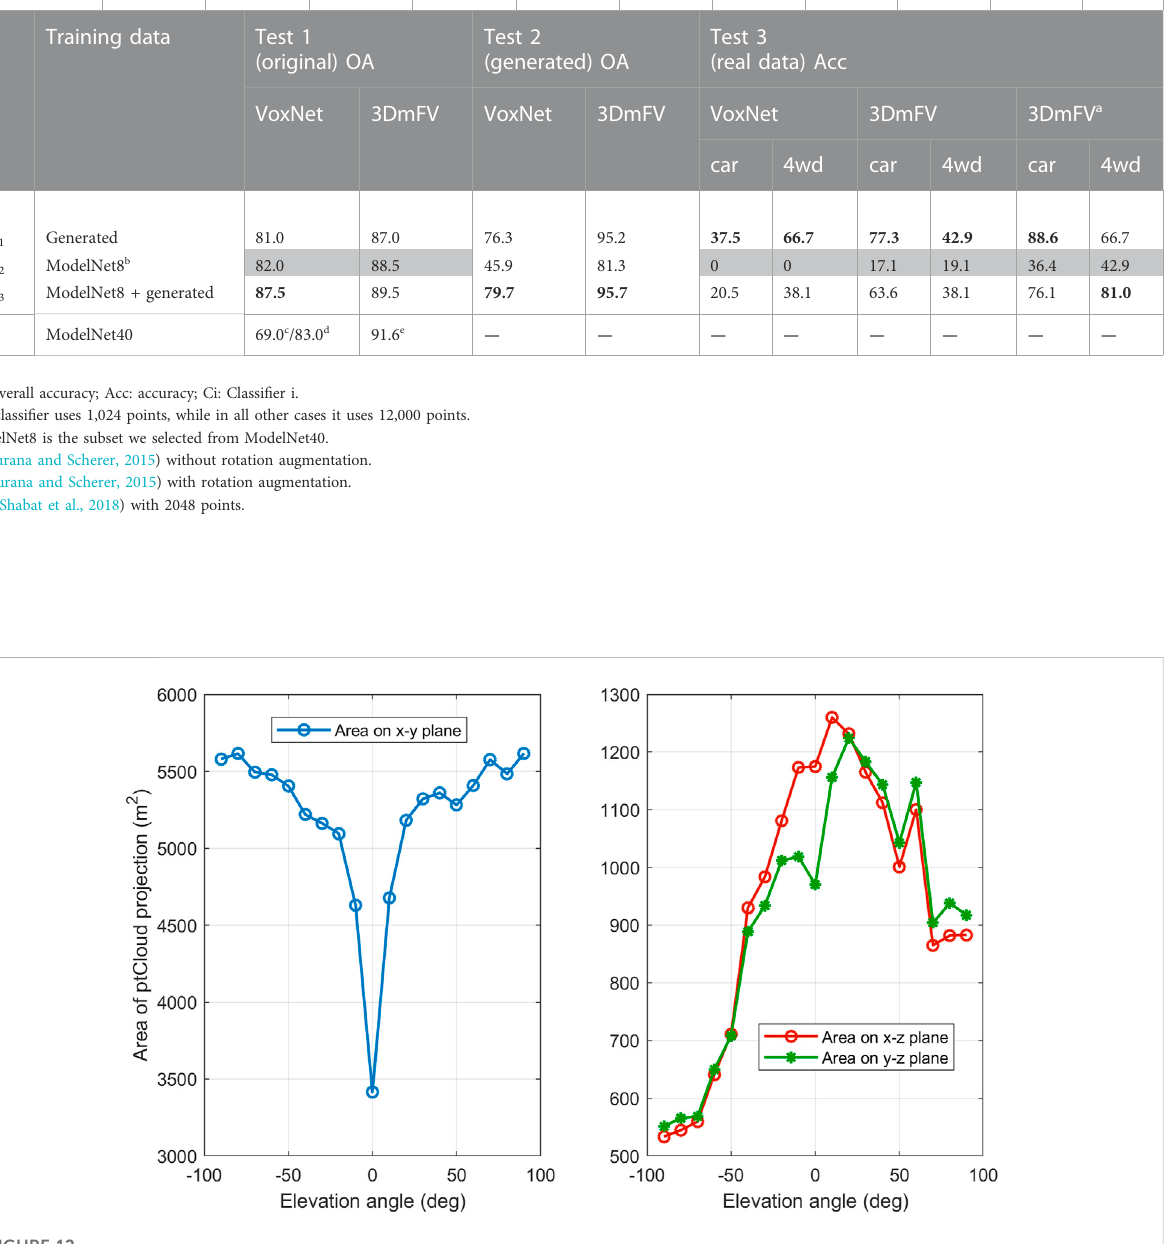
FIGURE 12 Projected area of the visible part of an object onto the three planes of the coordinates system as a function of the camera elevation